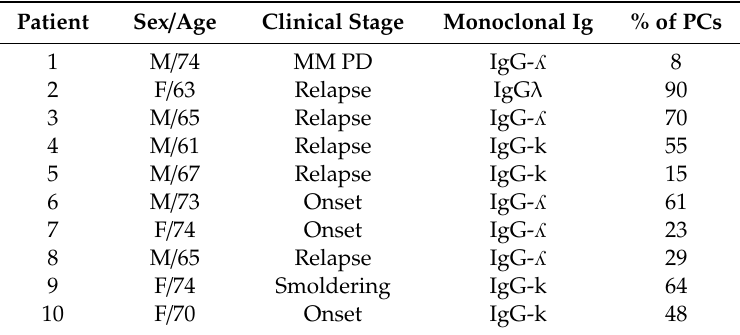
Table 1. Clinical parameters of MM patients used for the analysis of PVR surface expression and mRNA. Patients were classified according to Durie and Salmon’s Staging